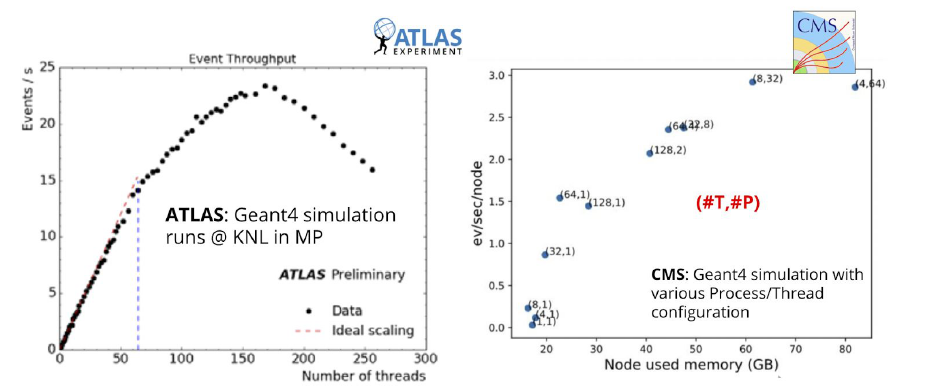
Fig. 2. Left: event/s from ATLAS MP simulation on KNL, up to HT4x; Right: throughput and ​ memory utilization (Minimum Bias events) with varying configurations in ( Process, # of Processes per node)